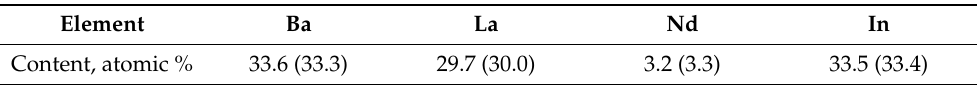
Table 3. The average element ratios determined by EDS analysis for the sample BaLa 0.9 Nd 0.1 InO 4 (theoretical values are in